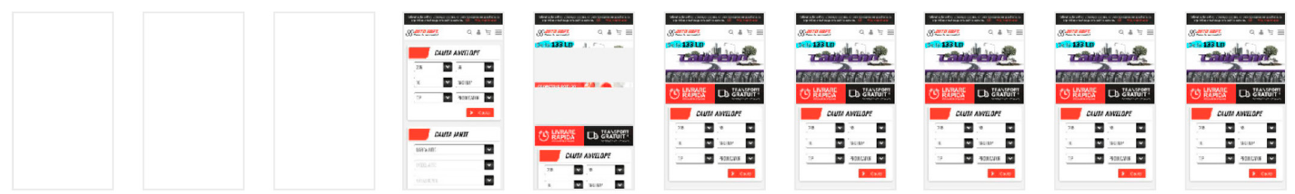
Figure 5. The chronology of content loading for auto-soft.ro.